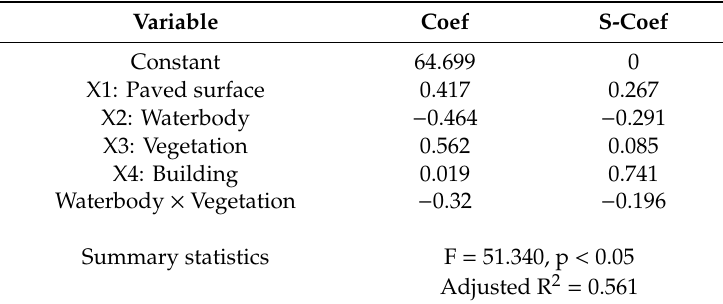
Table 3. Coe ffi cients of partial least square regression (PLSR)